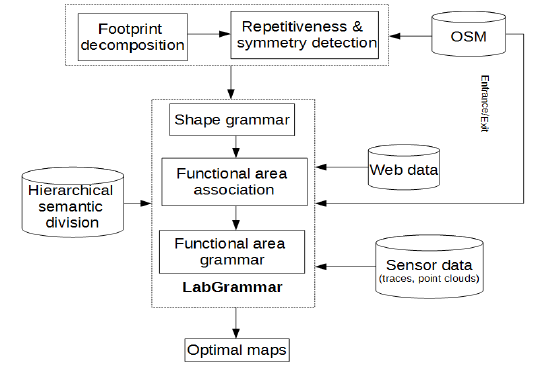
Figure 1. Conceptual framework